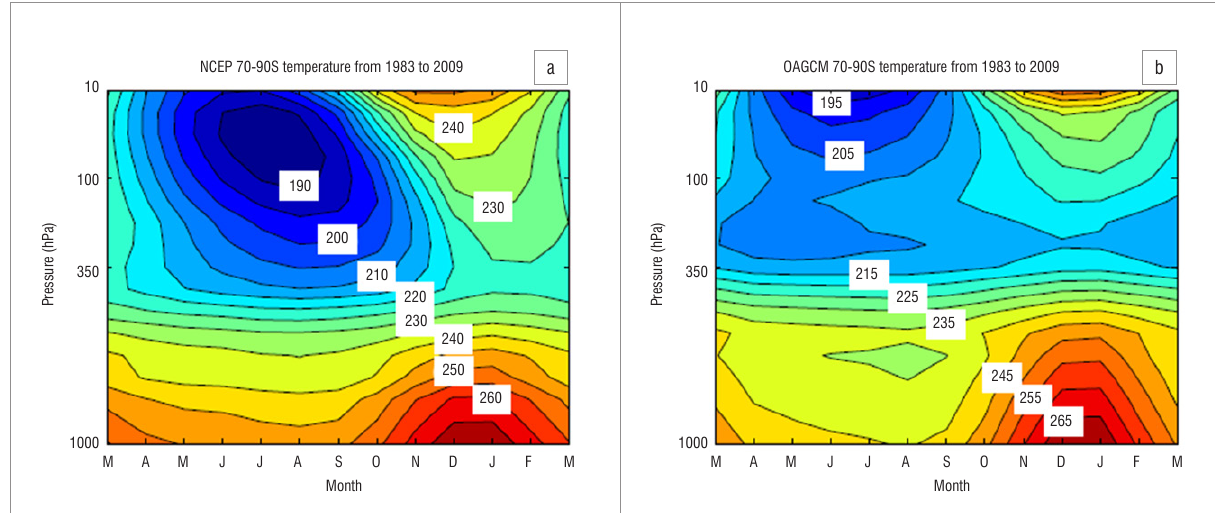
Figure 2: Polar cap temperature evolution as a function of month and pressure for (a) NCEP and (b) OAGCM. The contour intervals are 5